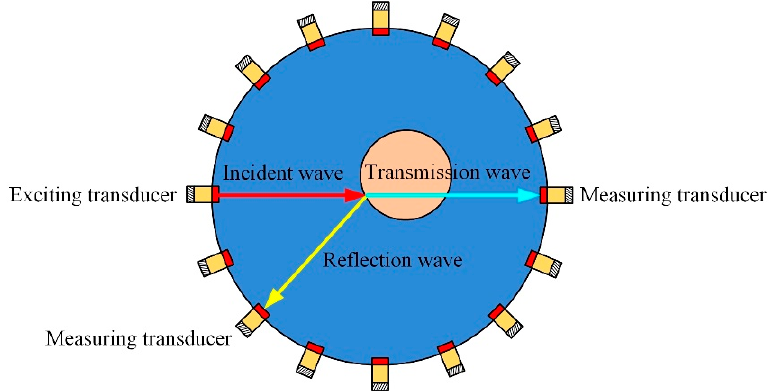
Figure 1. Ultrasound transmission and reflection physical model.